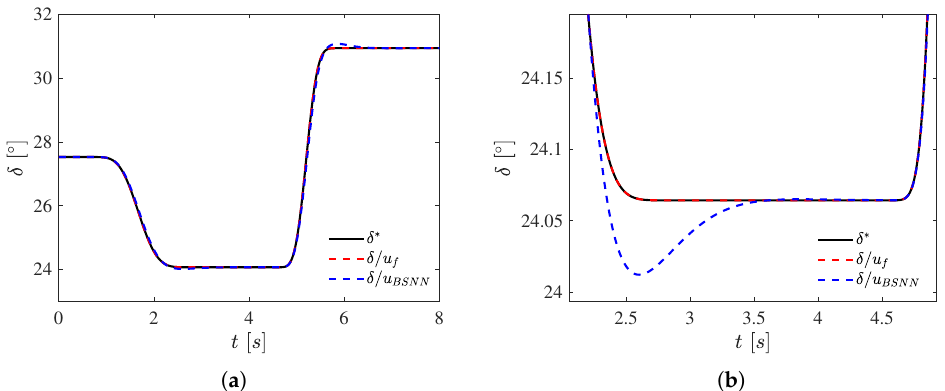
Figure 3. Load angle response at generator of SMIB system: ( a ) δ ; ( b ) zoom of δ when the reference value is decreased.